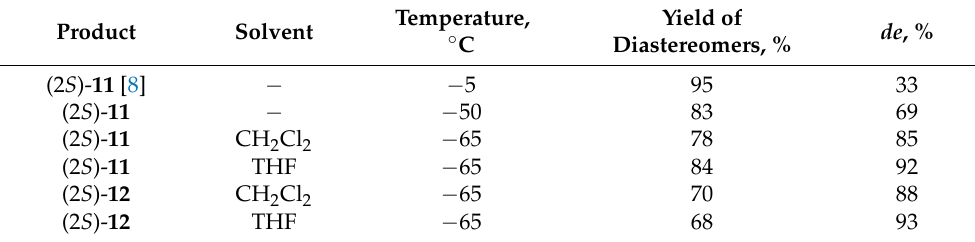
Table 1. Effect of reaction conditions on the stereoselectivity of the formation of ( S )-acyl derivatives (2 S )- 11 and (2 S )- 12 ( de ) (synthesis time 5 h).